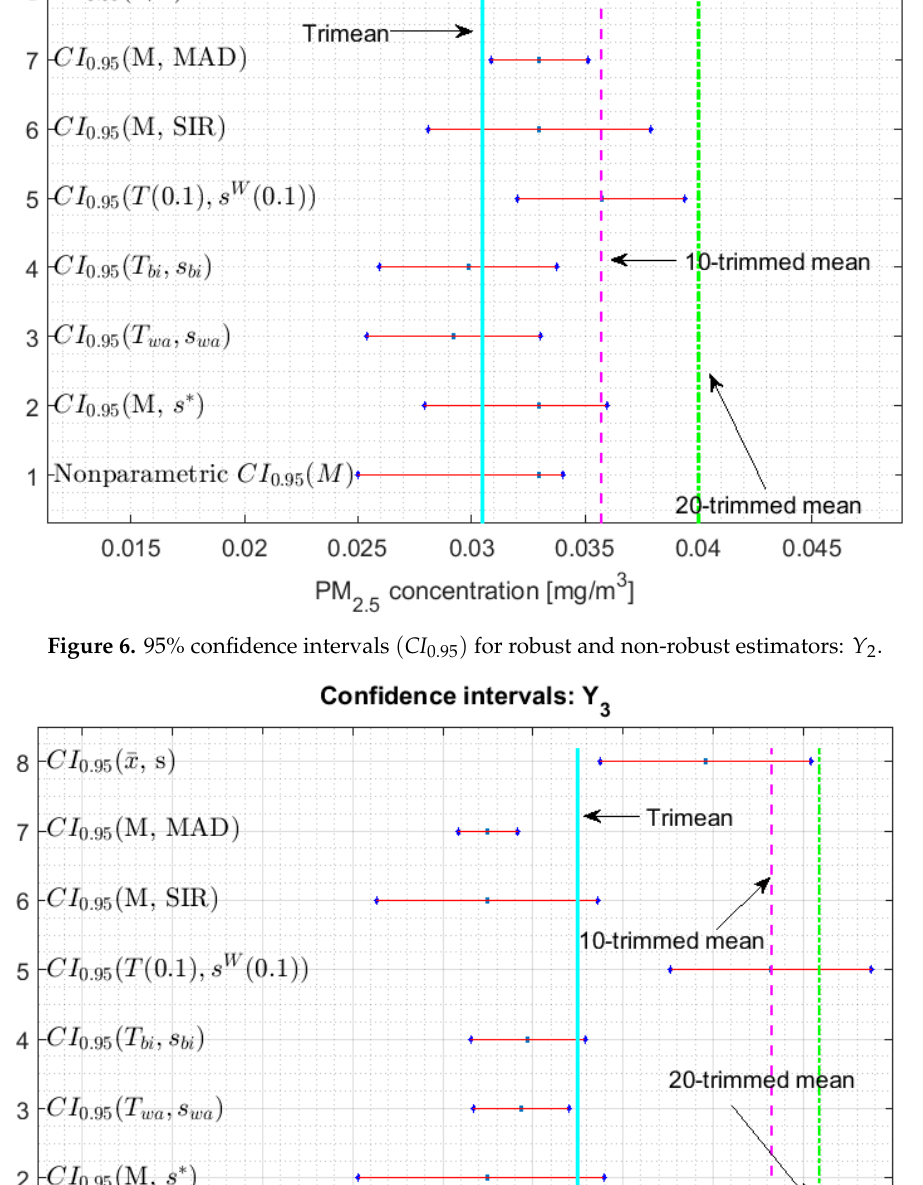
Figure 5. 95% confidence intervals (𝐶𝐼 (cid:2868).(cid:2877)(cid:2873) ) for robust and non-robust estimators: 𝑌 (cid:2869) .